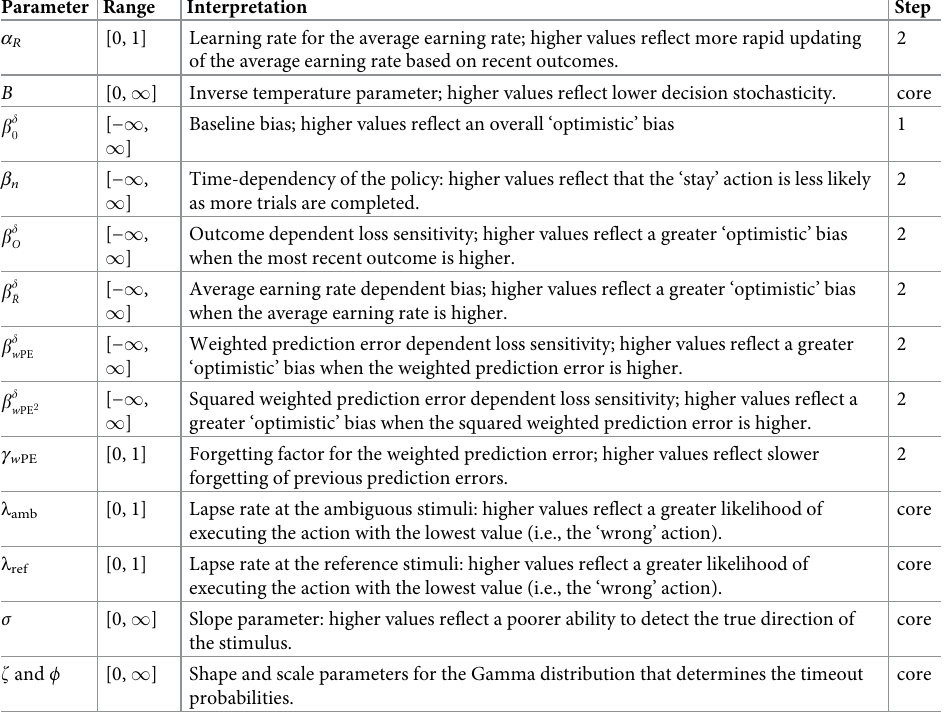
Table 2. Glossary of parameters in the POMDP model of judgement bias, including the range of values that each parameter can take and the step at which they were added in stepwise model-fitting procedure. Parameter